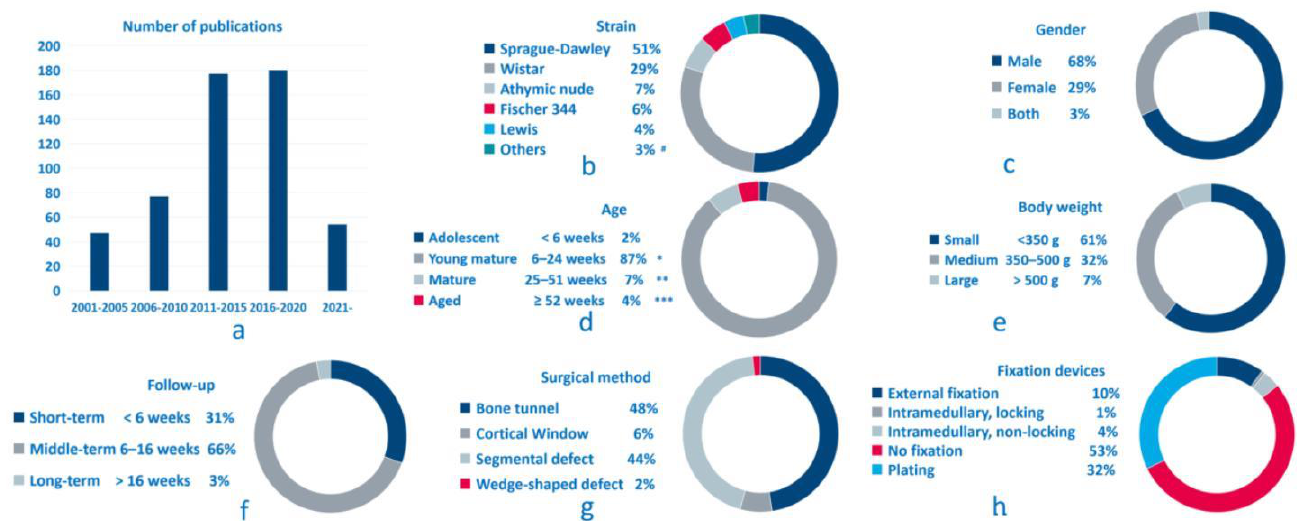
Figure 2. Summarized information of the included studies. ( a ) Number of publications; ( b ) rat strains involved; ( c ) gender; ( d ) age; ( e ) body weight; ( f ) longest follow-up; ( g ) modeling method; ( h ) fixation devices. Note: * including 6 weeks; ** including 6 months; *** including 12 months; # other rat strains: Long-Evans, Brown Norway, Dark Agouti, BB/OK, Zucker diabetic fatty; spontaneously